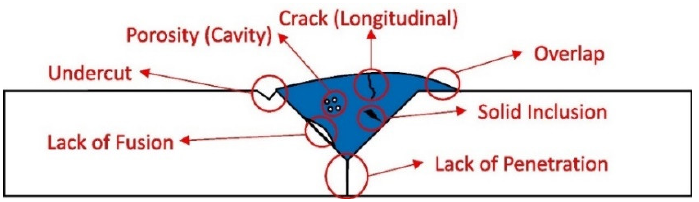
Figure 9. Common weld defects [3]. Reprinted with permission from ref. [3]. Copyright 2021 Elsevier.